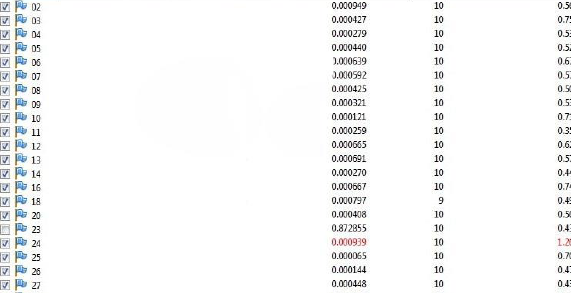
Table 5. Canon calibration parameters